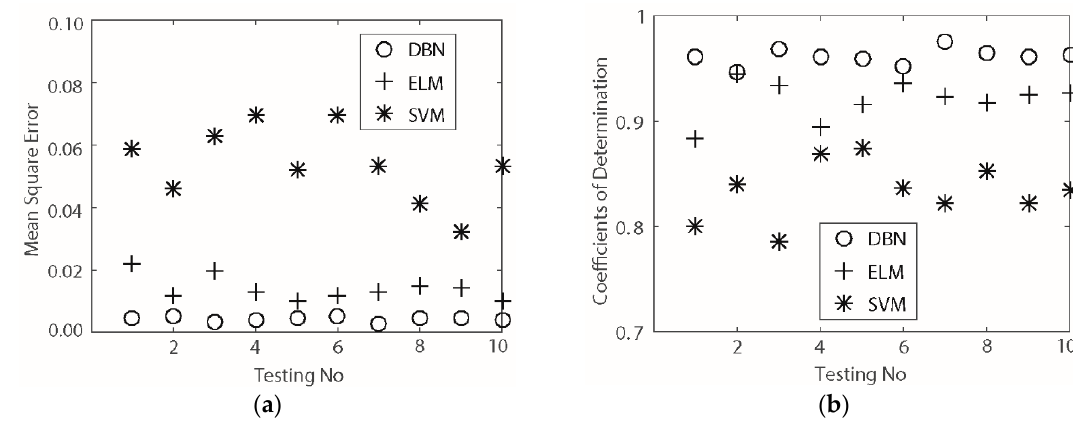
Figure 5. The predicted mean square errors ( a ) and determination coefficients ( b ) among the DBN, extreme learning machine (ELM), and support vector machine (SVM) models.